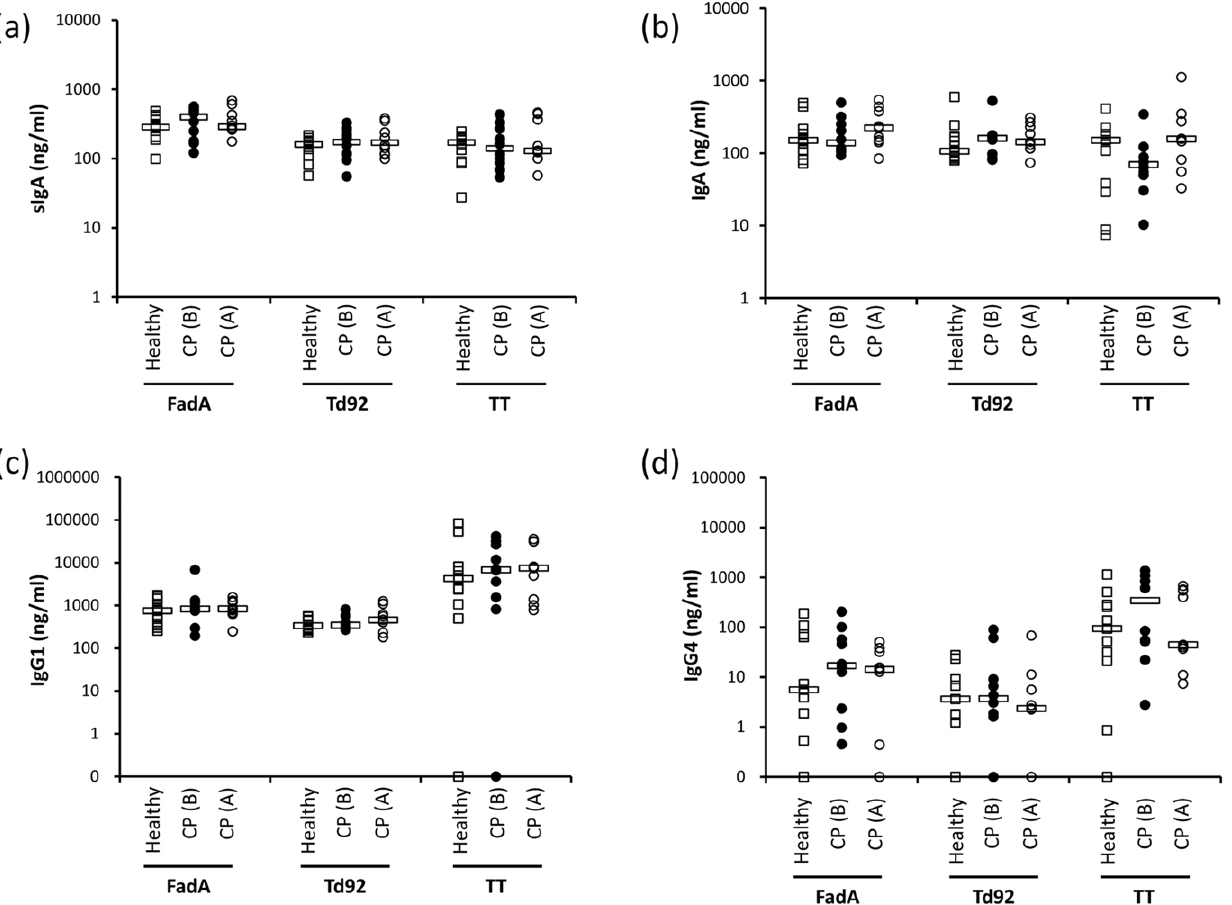
Figure 1. FadA-, Td92-, and TT-specific Abs in saliva and plasma. The levels of FadA-, Td92-, and TT-specific-IgA in saliva (a) and the Ag- specific-IgA (b), -IgG1 (c), and -IgG4 (d) in plasma were determined by ELISA. Bars indicate median values. CP (B): patients with chronic periodontitis before treatment. CP (A): patients with chronic periodontitis after treatment. doi:10.1371/journal.pone.0053703.g001 PLOS ONE |